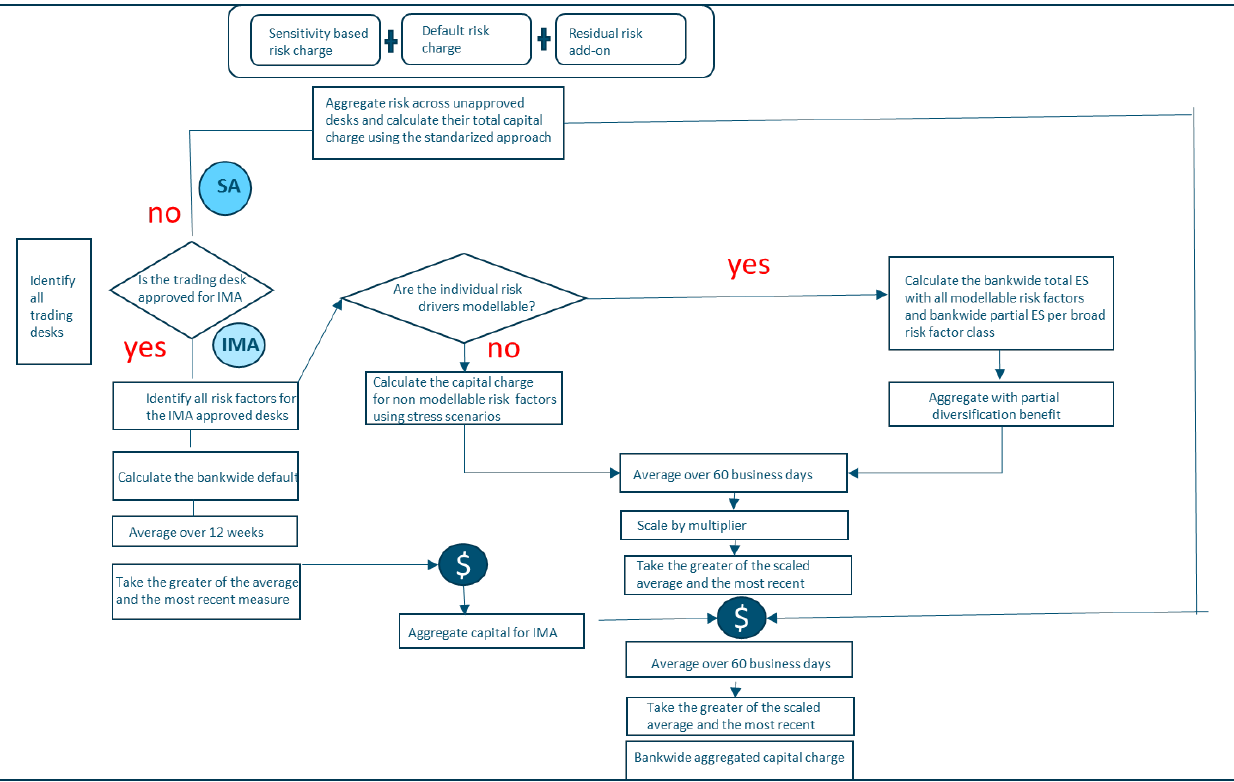
Figure 9. One possible decision tree for the implementation of FRTB (adapted from Capteo